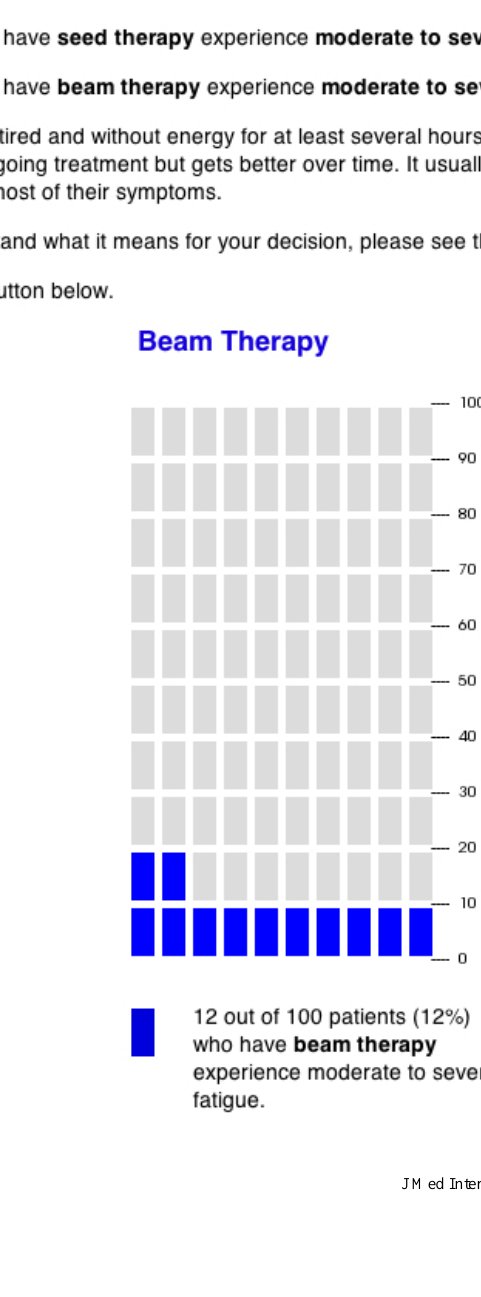
Figure 1. Screen image of the static